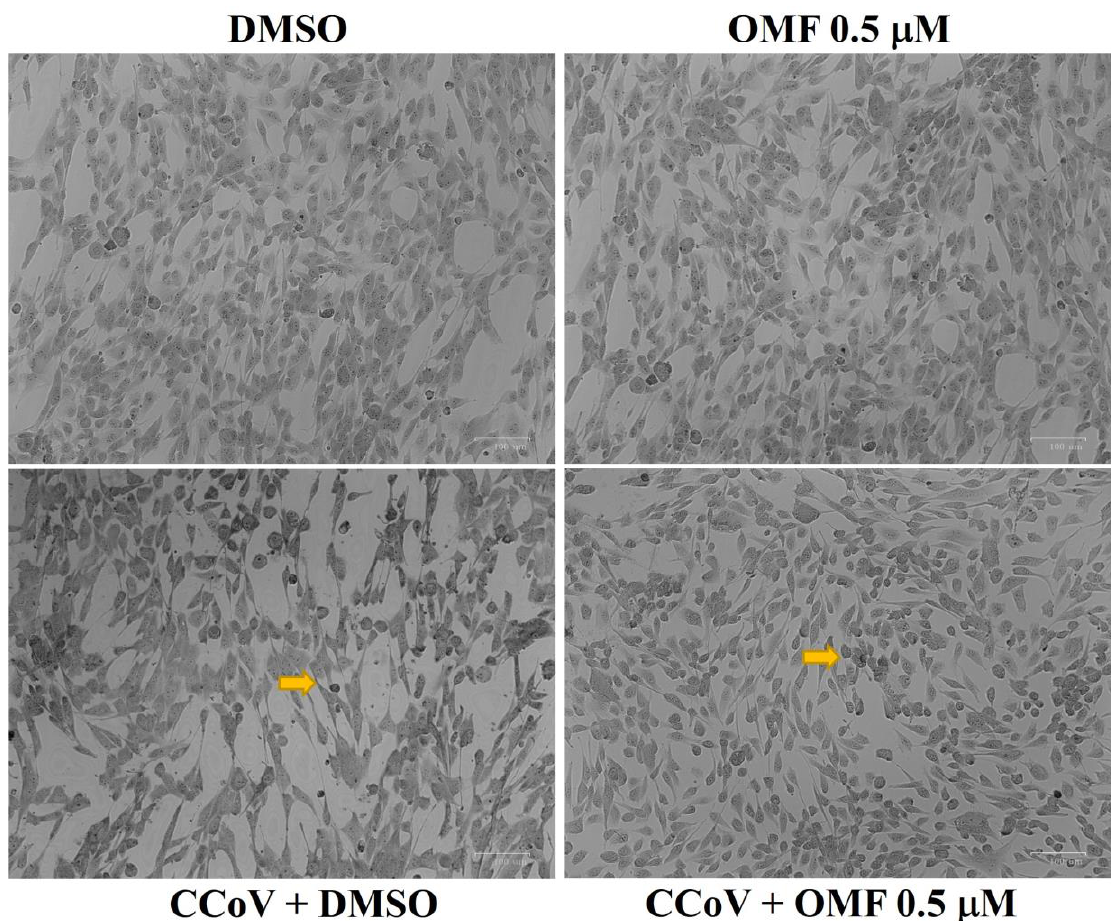
Figure 4. OMF diminished signs of morphological cell death during CCoV infection in A72 cells. Cells were infected with CCoV, exposed or not to OMF. After 48 h of infection, cells were observed under a light microscope after Giemsa staining. Comparing cells unexposed to OMF to control groups, photomicrographs revealed no morphological changes. In CCoV-infected groups, several cells showed signs attributable to apoptosis, such as pyknotic nuclei and nuclear fragmentation (arrow), whereas in OMF-treated infected cells, few signs of apoptotic cell death were noticed (arrow). Scale bar 100 μ m.